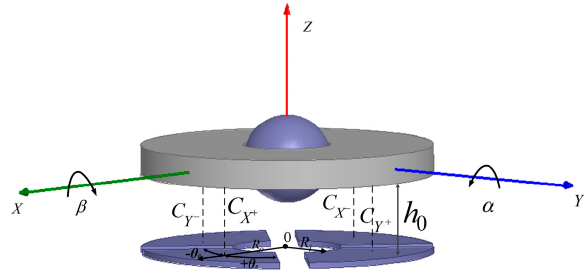
Figure 7. Schematic diagram of differential pairs testing α and β .